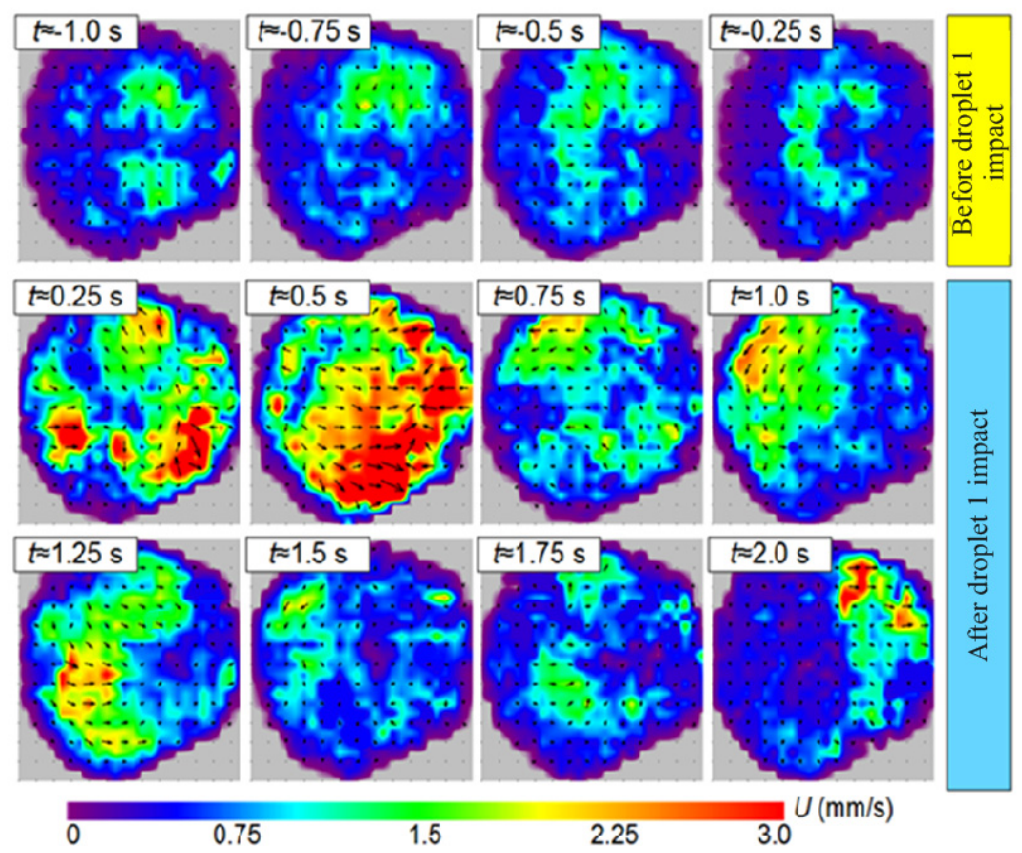
Figure 10. Velocity field in horizontal section of drop 2; V 01 = 2.5 µ L; V 02 = 40 µ L; T w = 80 ◦ C; T 01 = 20 ◦ C; water (drop 2), water + surfactant OP-10) (droplet 1).